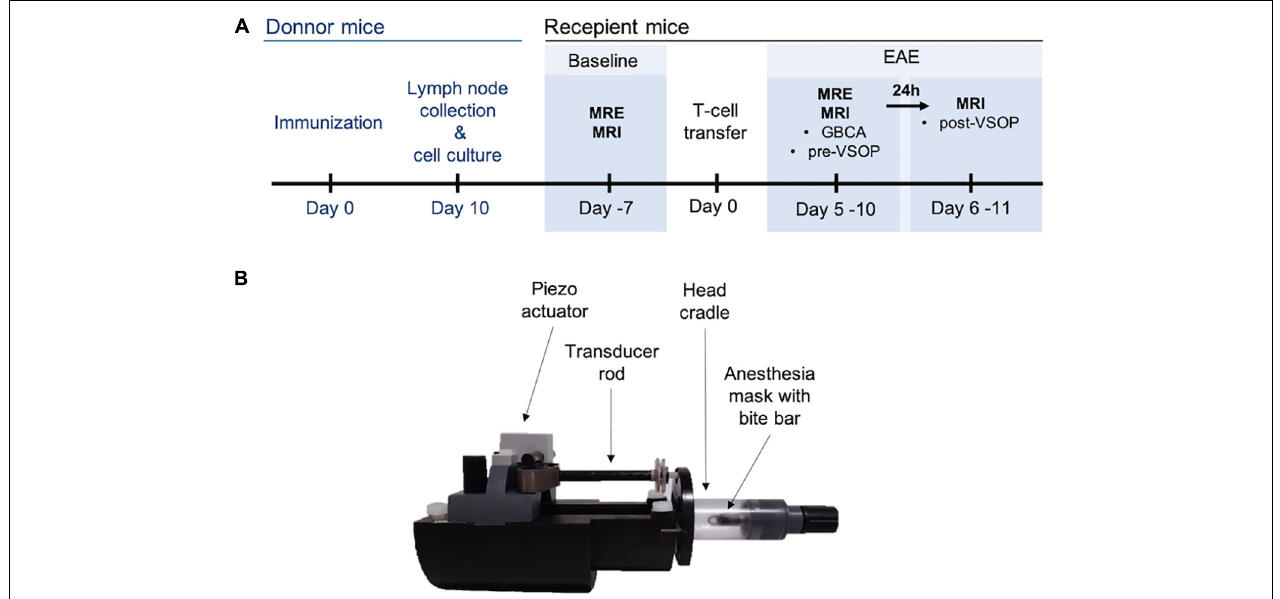
FIGURE 1 | Experimental set-up. (A) Timeline depicting induction of adoptive transfer EAE and in vivo scans at baseline, before immunization, and after establishment of EAE. (B) Custom-made animal holder. A piezo actuator generates the mechanical waves, which are transmitted via the transducer to the head cradle and into the skull of the mouse.